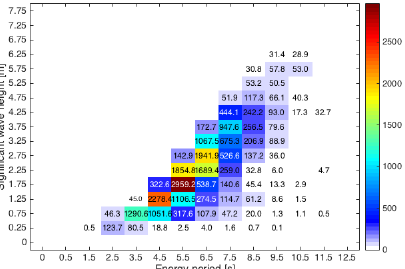
Figure 9. Annual energy production in kWh at Site 6 with a damping coefficient of 60 kNs/m. The red square at (5.5 s, 1.75 m) gives the highest percentage among all the sea states.